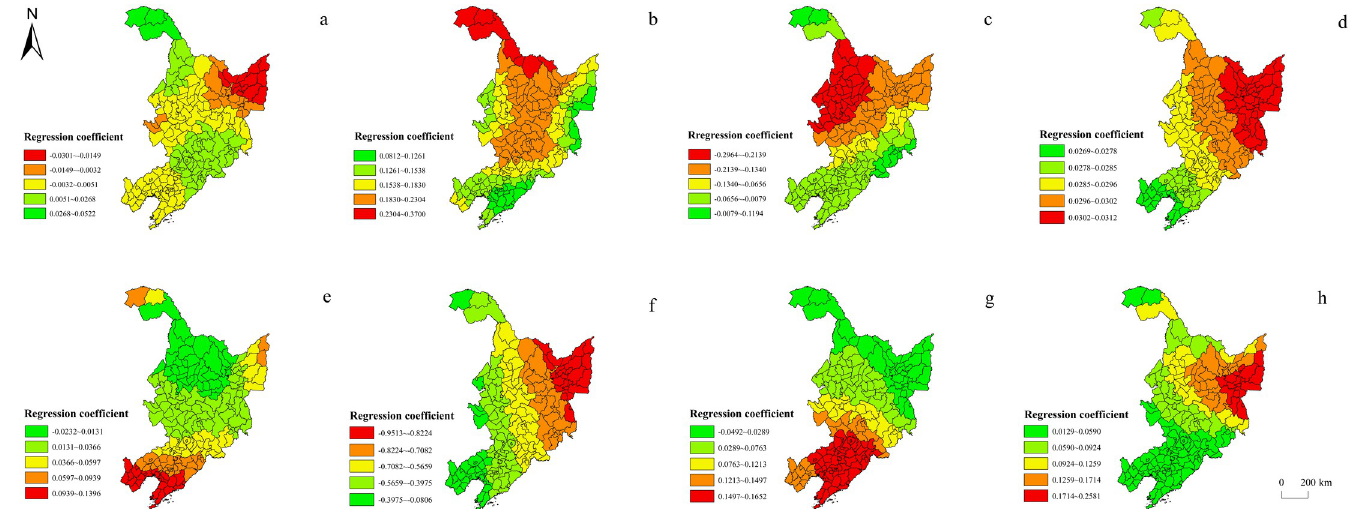
Fig 7. Spatial distribution of the regression coefficients of influencing factors based on GWR. a. altitude; b. the proportion of the secondary industry; c. the proportion of the tertiary industry; d. the output value of agriculture, forestry, animal husbandry and fishery; e. the number of industrial enterprises above the designated size; f. population aging; g. fiscal expenditure; h. the balance of resident deposits. Note: The basic map came from a public map from the standard map service website of the Ministry of Natural Resources of China. The drawing approval number is GS (2016)1593.